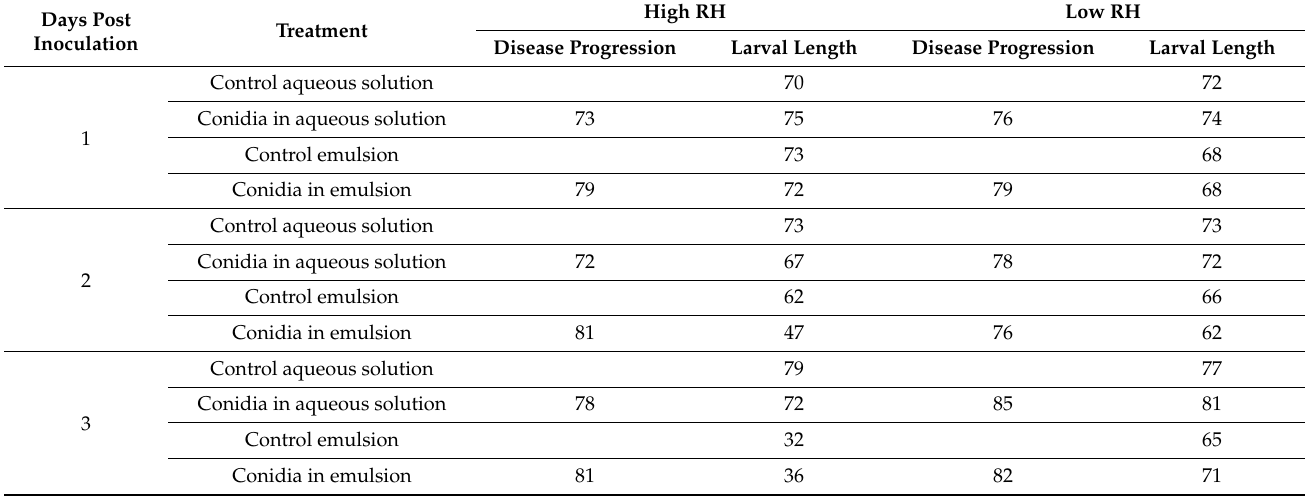
Table 1. Total sample sizes of larvae used to assess disease progression and larval development (length) 1 . Days Post